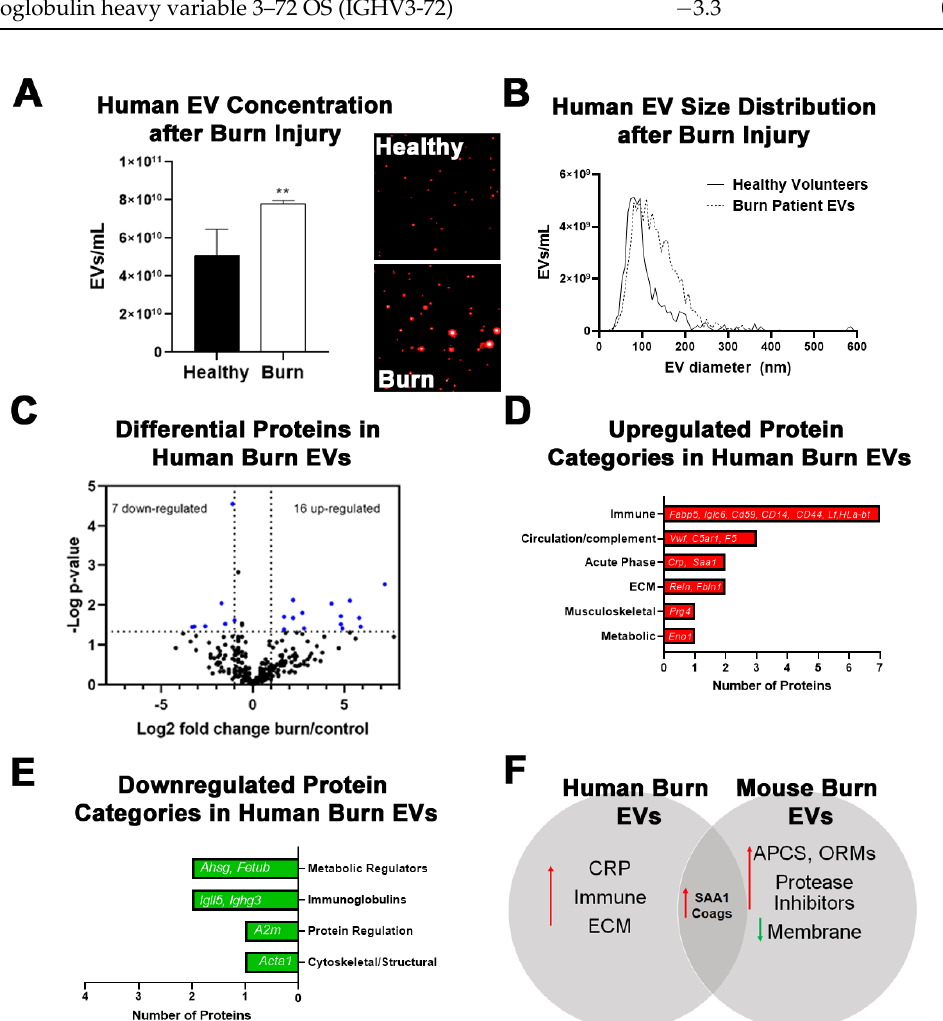
Figure 4. Proteomic changes in human burn patient plasma EVs. Plasma EVs from human burn patients with severe burn injury were isolated within 72 h of admission. Protein content was measured by LC-MS/MS. ( A ) EV number was measured by NTA. Human burn patients showed an increase in circulating plasma EVs compared to healthy donors. ** p < 0.01, n = 3/group. Inset shows representative images of EVs captured by the ParticleMetrix TM machine. ( B ) NTA size analysis shows the majority of EVs are in the 100–400 µm diameter size range, with burn EVs showing increased numbers in the MV size range. ( C ) Differentially expressed protein peptides in burn vs. healthy donor EVs (LFQ ratio, p -value Student’s t -test, n = 3 per group). ( D ) Characteristics of proteins that are increased in burn EVs relative to healthy individuals. ( E ) Characteristics of proteins that are decreased in burn EVs relative to healthy individuals. ( F ) Comparison of robust changes between human burn and mouse burn EVs. Both SAA1 and coagulation proteins were increased across